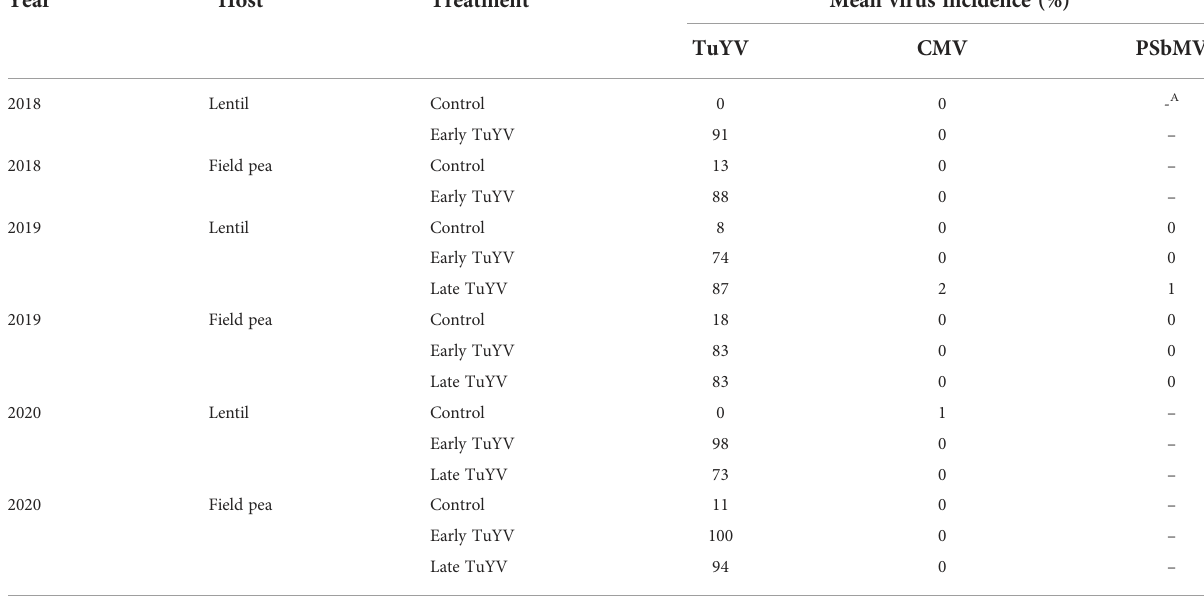
TABLE 2 Mean incidence (percentage of infected plants) of turnip yellows virus (TuYV), cucumber mosaic virus (CMV) and pea seed-borne mosaic virus (PSbMV) in plots of fi eld-grown lentil and fi eld pea for each treatment (i.e.- non-inoculated control, early TuYV infection and late